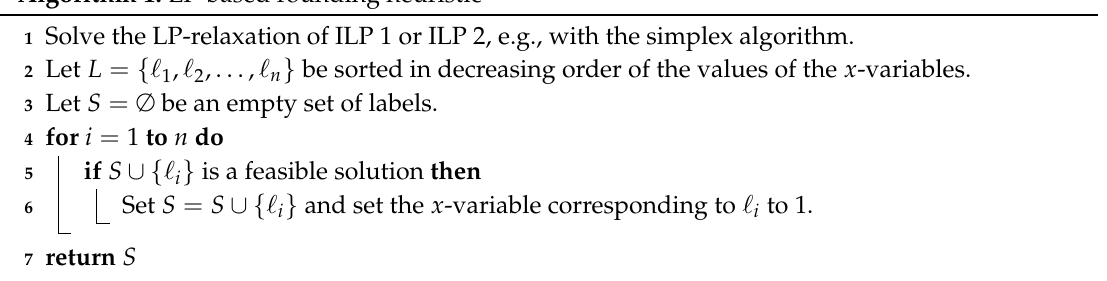
Algorithm 1: LP-based rounding